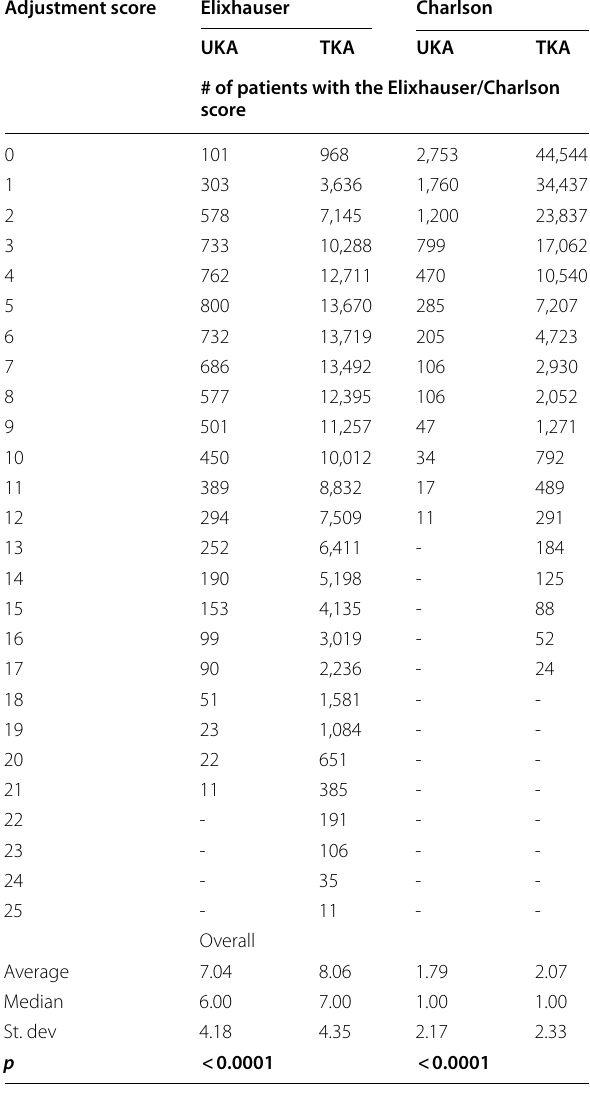
(Fig. 4; Table 11) at 8 years. Implant survival increased with advancing age (X 2 4.66). The highest rate of sur- = vival was seen in patients over 80-years-old (95.6%